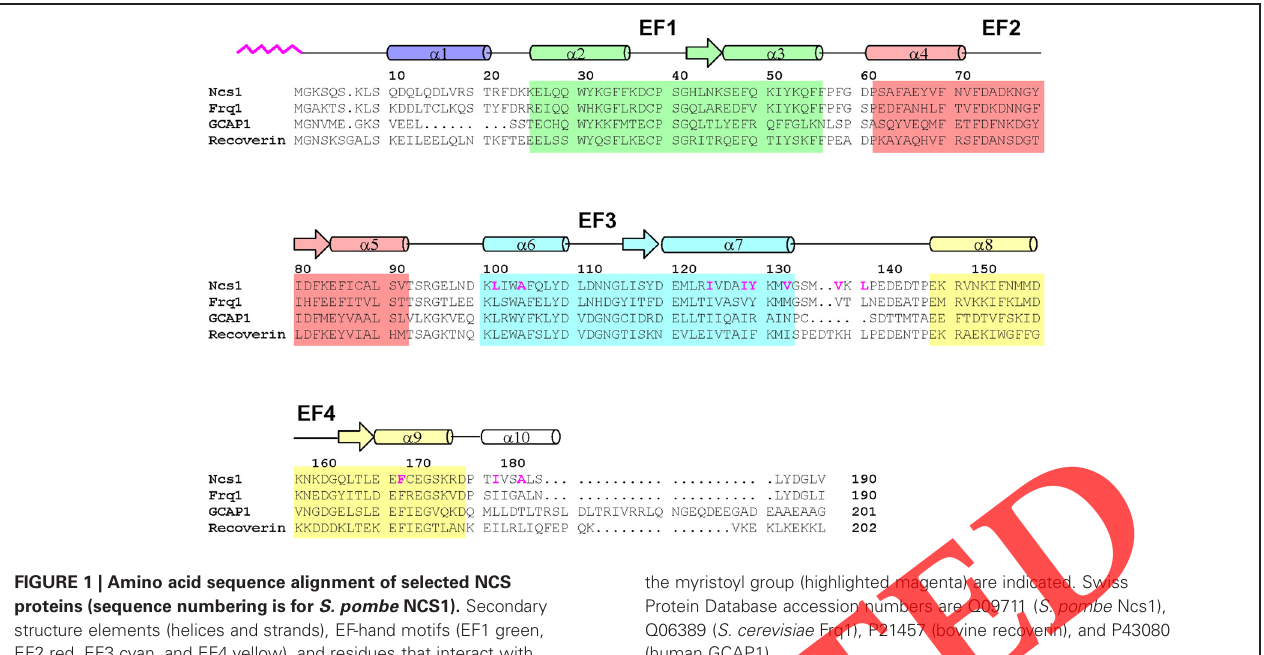
FIGURE 1 | Amino acid sequence alignment of selected NCS proteins (sequence numbering is for S. pombe NCS1). Secondary structure elements (helices and strands), EF-hand motifs (EF1 green, EF2 red, EF3 cyan, and EF4 yellow), and residues that interact with